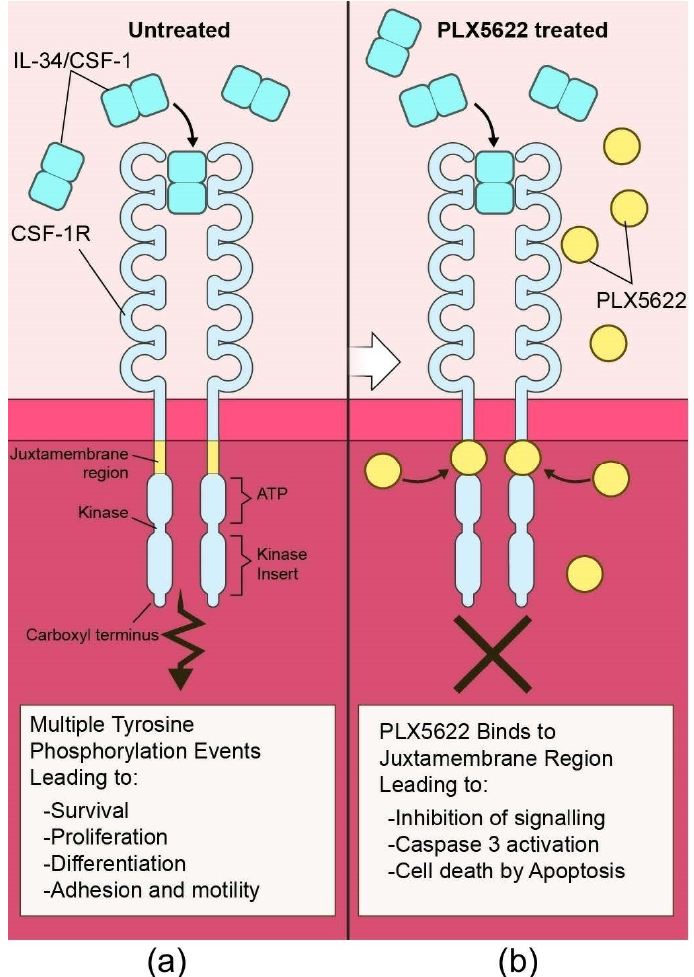
Figure 3. Representation of the CSF-1 Receptor (CSF-1R) interaction with the tyrosine kinase inhibitor PLX5622. Under normal conditions ( a ) CSF-1R interacts with either CSF-1 or IL-34 to promote phosphorylation at a minimum of eight tyrosine residues within the cytoplasmic domains. These phosphorylation sites serve as docking points for many proteins and lead to downstream signaling events. Inhibition of CSF-1R with PLX5622 ( b ) causes a cessation of signaling through this receptor in microglia, which is critical for their survival and proliferation. Microglia are eliminated from the CNS by activation of Caspase 3, leading to death by